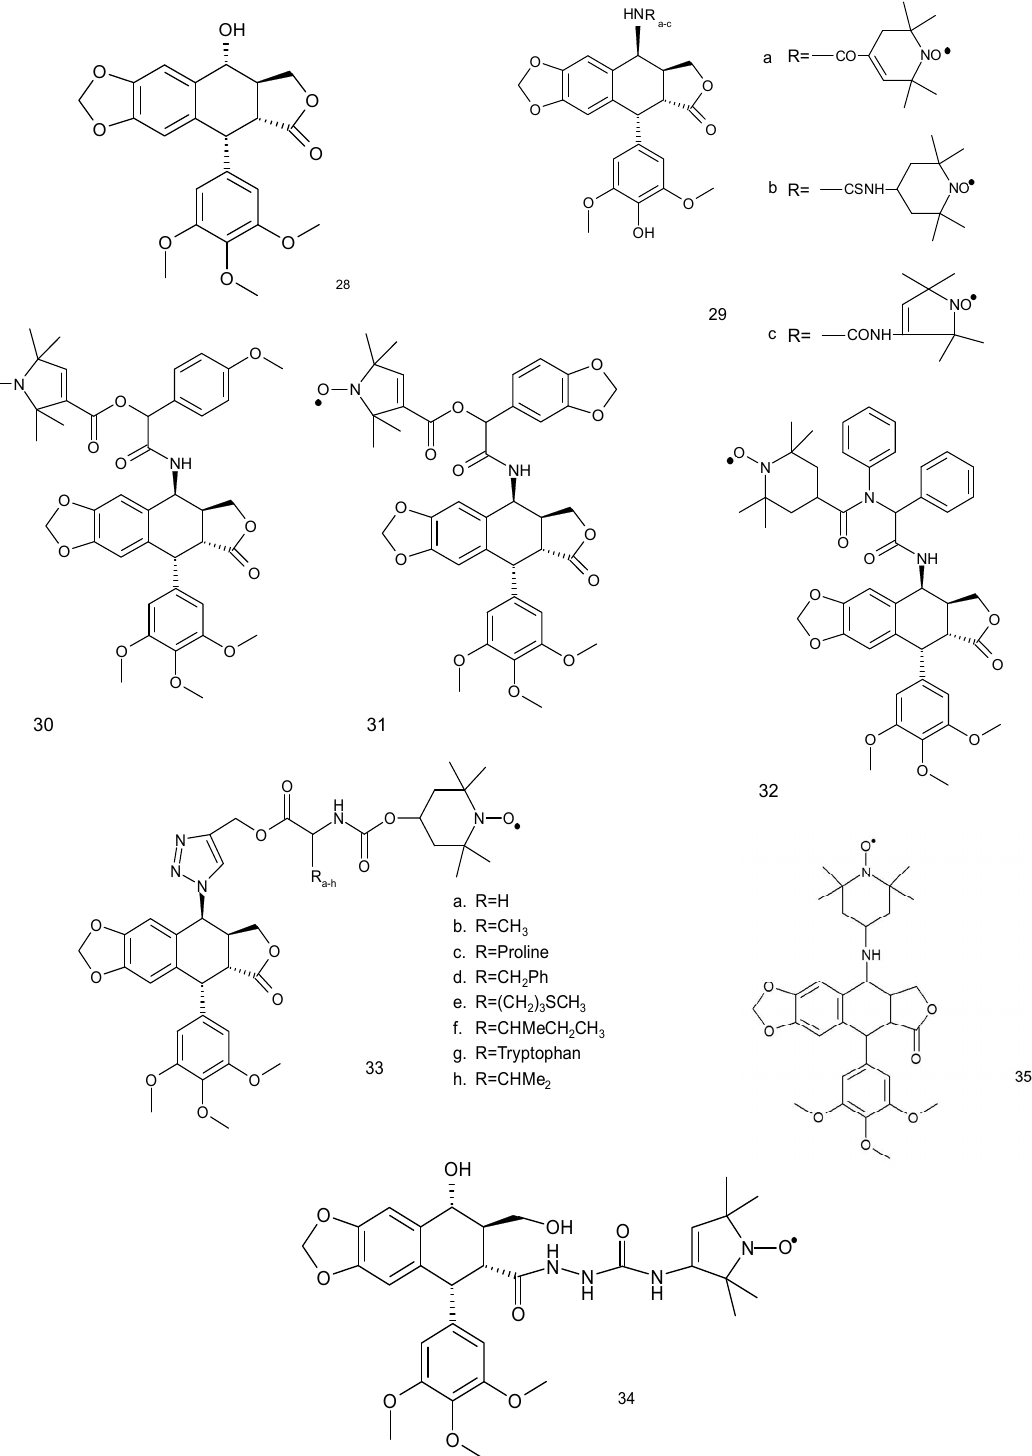
Figure 9. Podophyllotoxin and its spin-labelled derivatives: ( 28 ) podophyllotoxin, ( 29 – 35 ) spin-labelled podophyllotoxin derivatives.